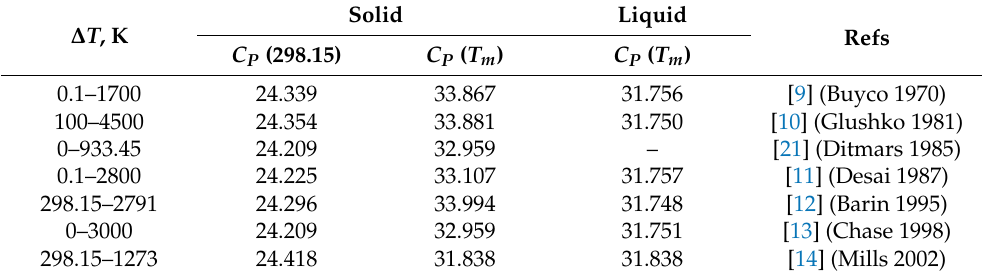
Table 1. Data on thermodynamic properties of solid and liquid aluminum ( C P , J · mol − 1 · K − 1 ) taken from reference books and review